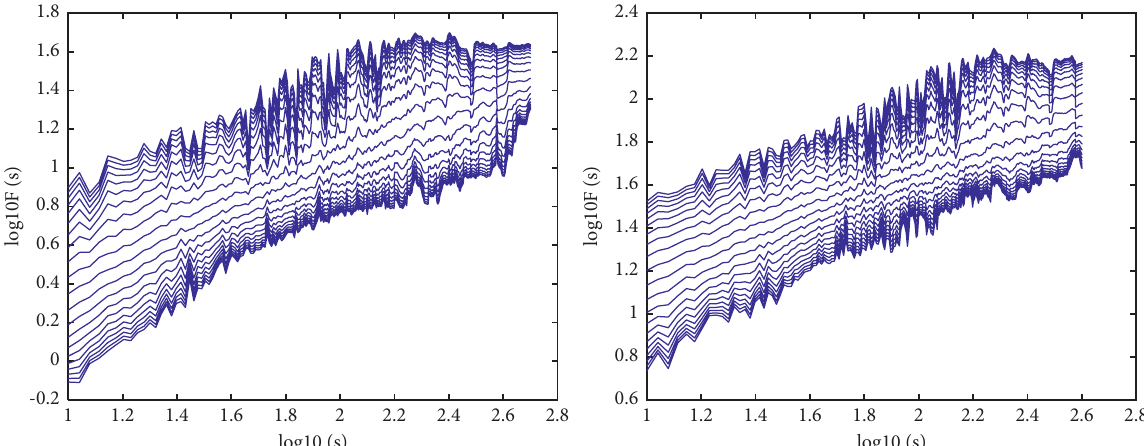
Figure 3: The log-log plots of F ( s ) versus s between the foreign flows in A-share market and VIX and the foreign flows in A-share market q and US EPU. The order of q increases from the bottom to the